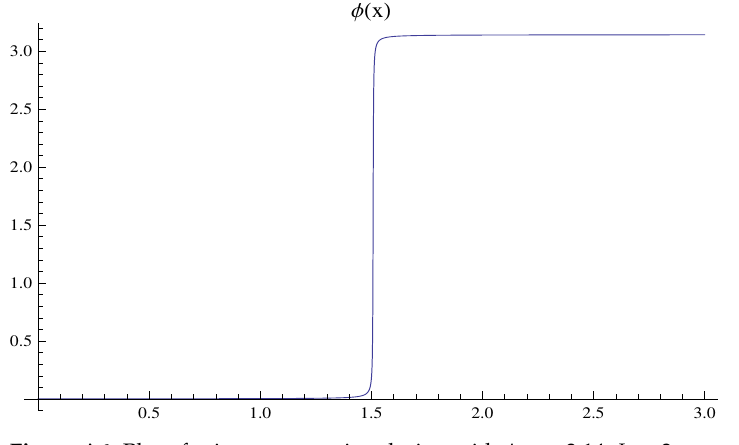
Figure A6. Plot of ϕ in a symmetric solution with ∆ ϕ (cid:39) 3.14, L =